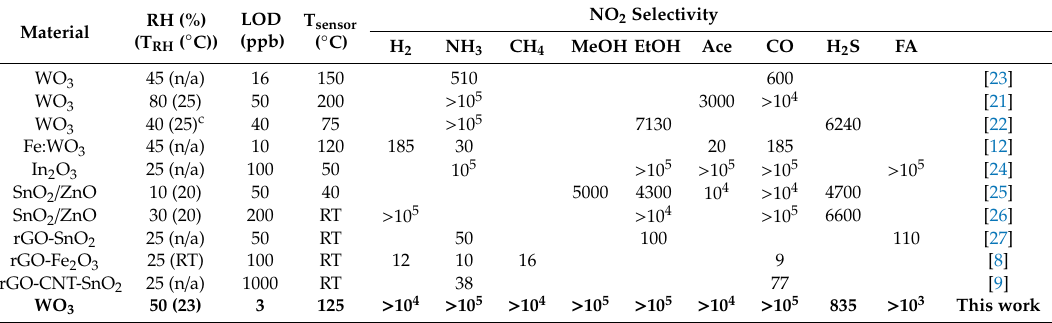
Table 1. Literature comparison. Selectivity, relative humidity (RH), sensing temperature (T sensor ), and lower limit of detection (LOD) of state-of-the-art solid-state NO 2 sensors tested at humid conditions. The LOD represents the lowest concentration measured in the respective study. Responses were linearly interpolated to the same concentrations. Non-conventional abbreviations: RT: room